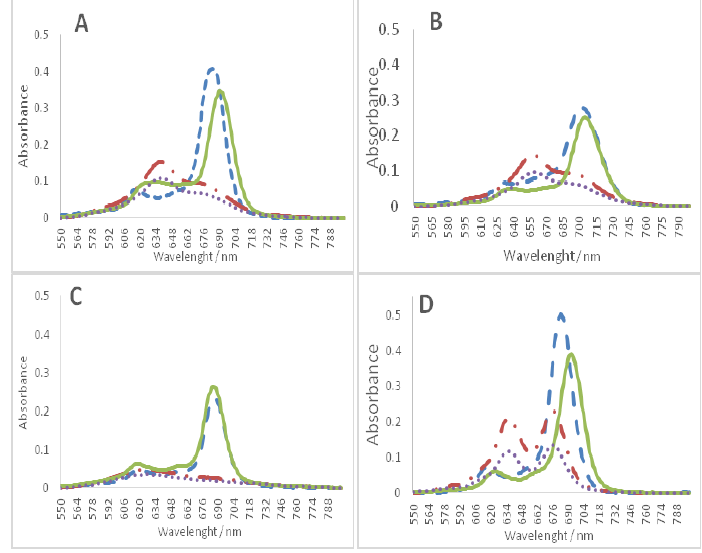
Figure 7. UV-Vis spectra of Pcs (2.0 µ M) in DMSO ( --- ), in PBS ( - . - ), and PBS + 200 µ L PBS (.....), PBS + 200 µ L GQ (T 2 G 5 T) 4 ( — ); ( A ) ZnPc1, ( B ) ZnPc2, ( C ) ZnPc3, ( D )